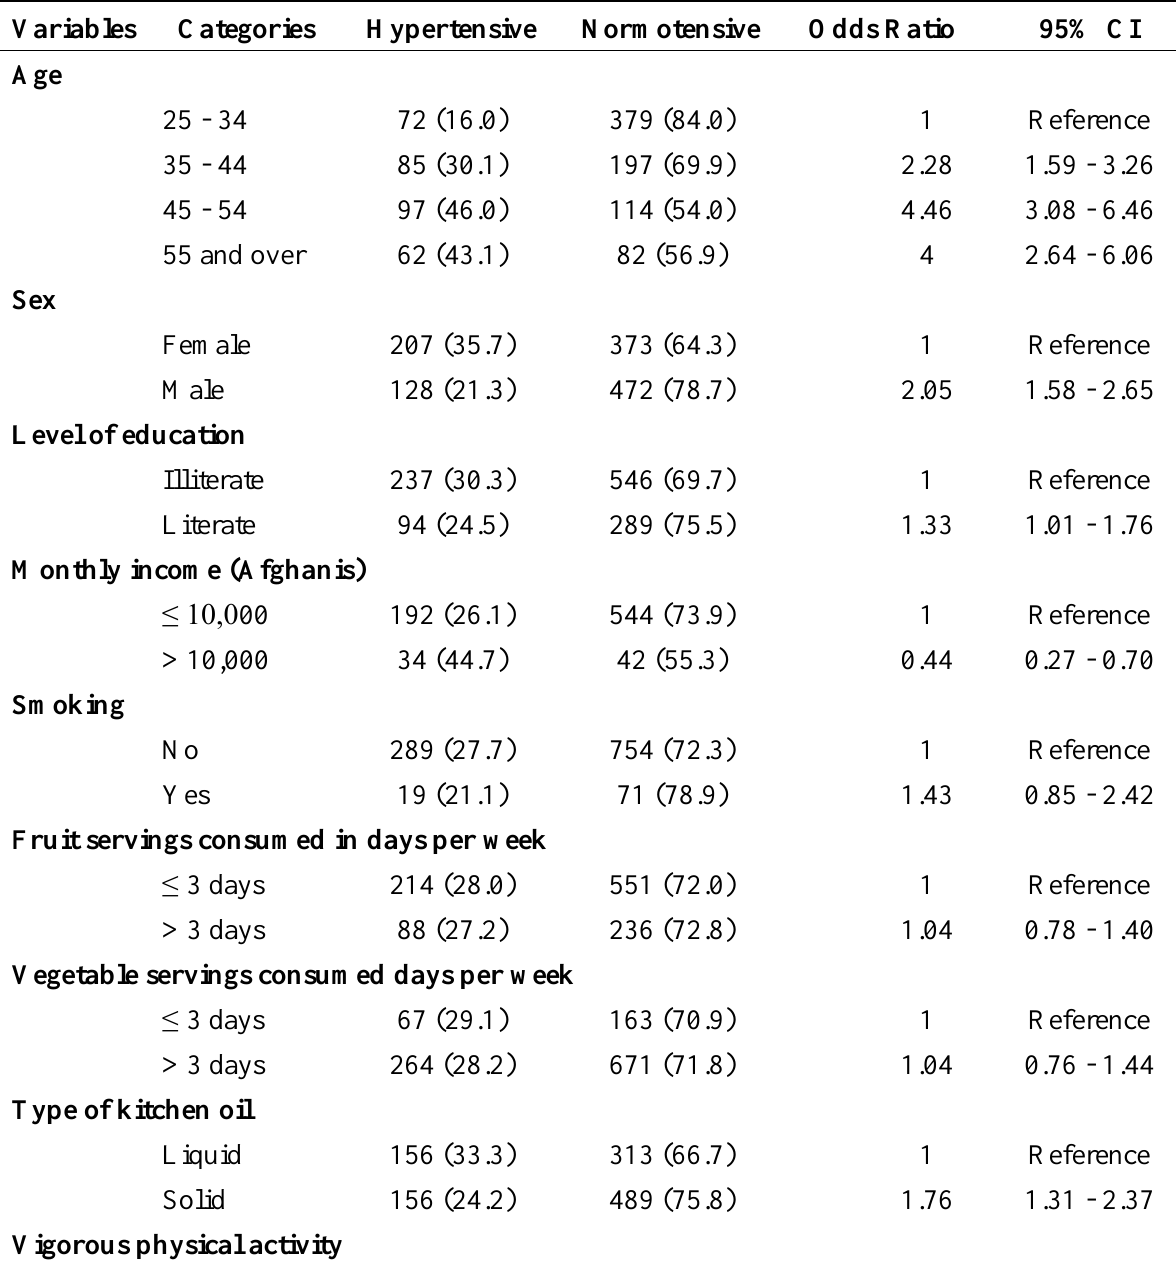
Table 3: Bivariate analysis of bio demographic and socio-economic factors and hypertension among those surveyed using the WHO STEPS in Jalalabad, Nangarhar,